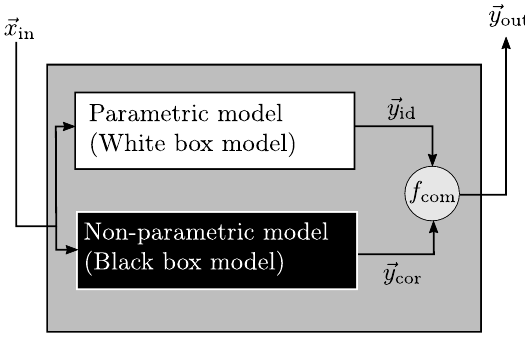
Figure 1. Approximator/Corrector scheme of a parallel grey box model